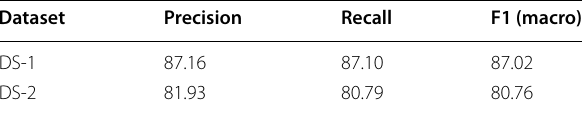
Table 7 Concept drift analysis of trigger-enhanced campaign stages classification model